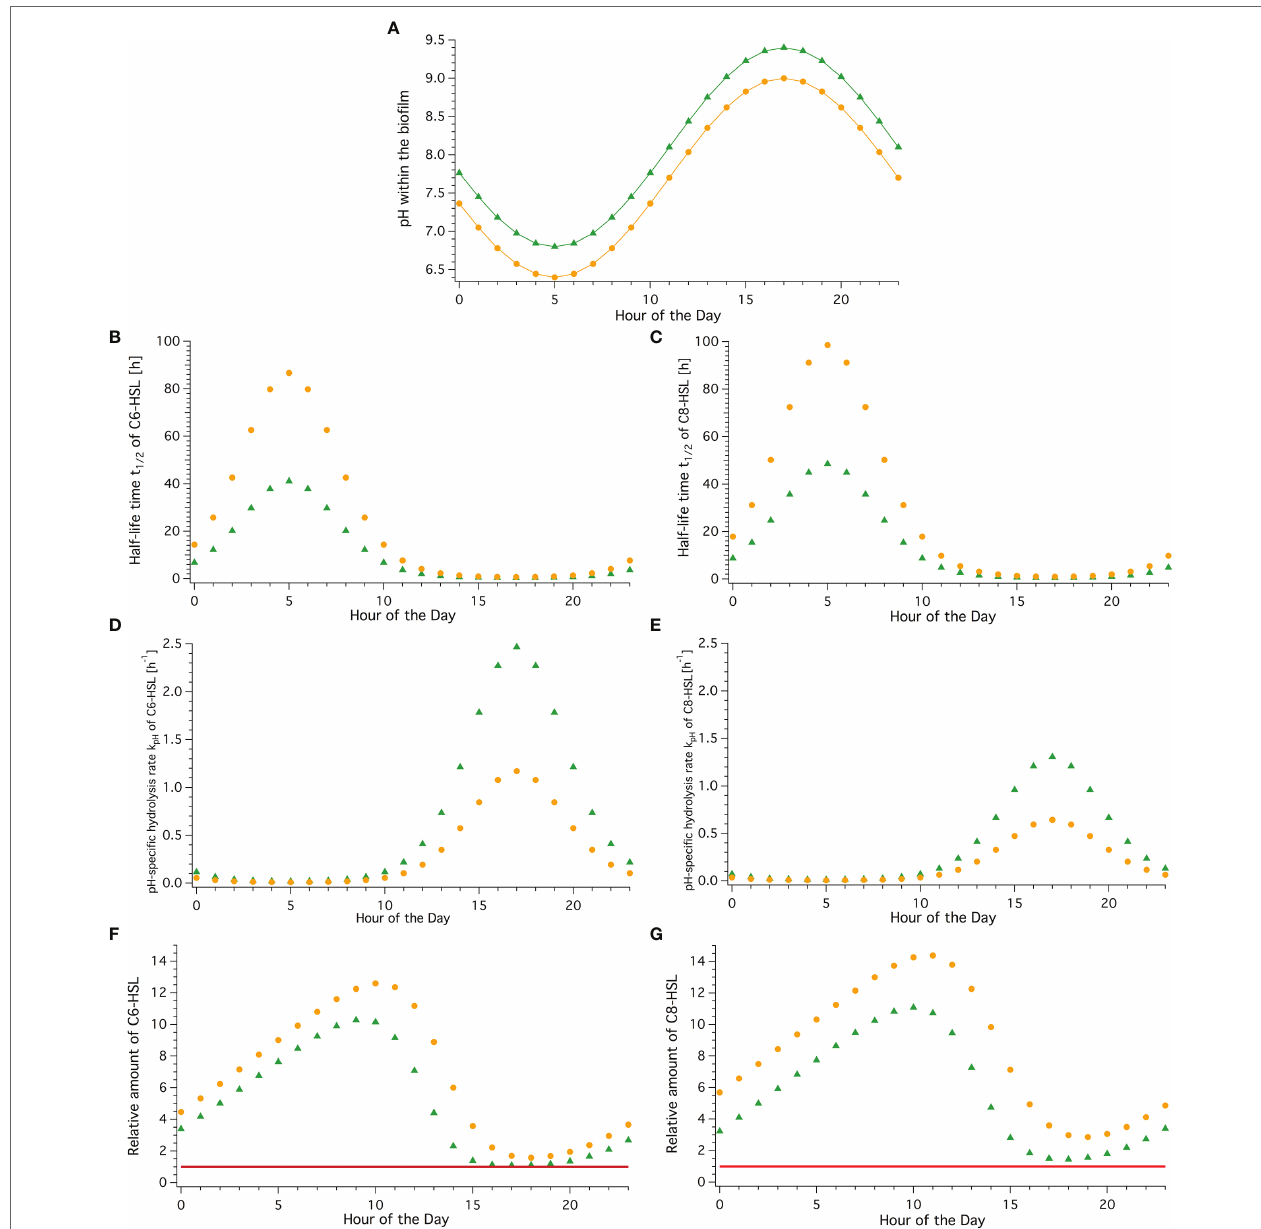
FIGURE 5 | Current and future concentrations of C6-HSL and C8-HSL over a daily pH-cycle within a biofilm. Green triangles represent values in current conditions, yellow dots represent values in the year 2100 with predicted reduction in pH due to climate change. (A) Periodically fluctuating pH-conditions based on Decho et al. (2009) assuming stable temperature. (B, C) Half-life time in hours across a daily cycle for C6- and C8-HSL, respectively. (D, E) Hydrolysis rate k pH over the course of the day for C6- and C8-HSL, respectively. (F, G) Relative amount of C6- and C8-HSL for every hour in a daily cycle. Amount produced is normalized to 1 (red line), so relative amount value reflects multitude of produced amount